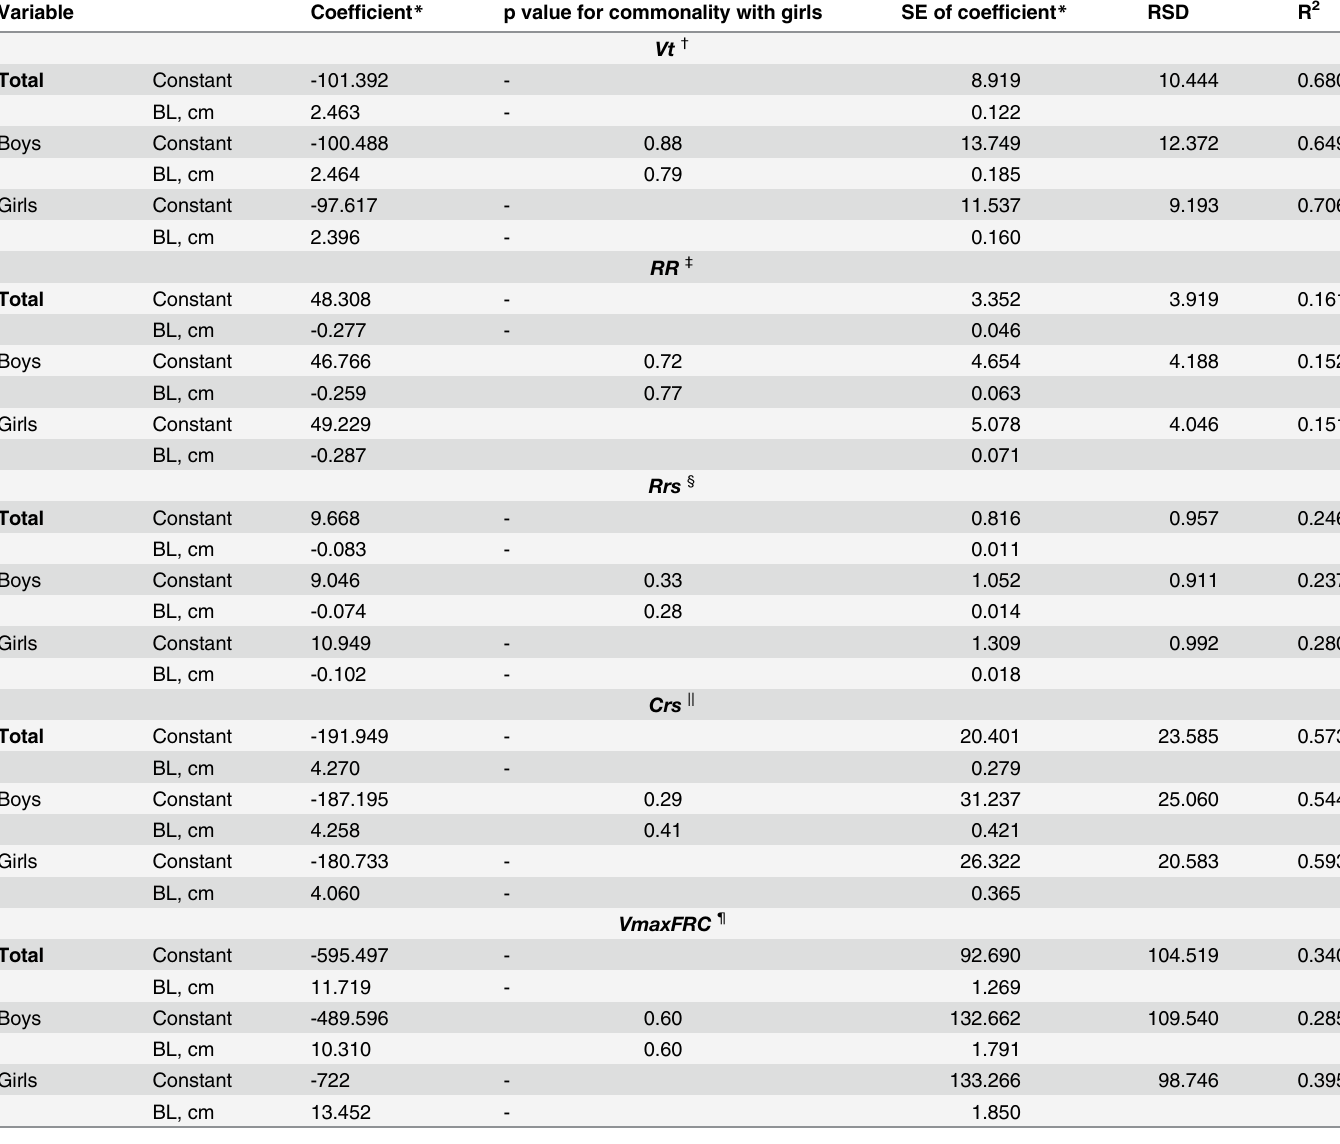
Table 4. Regression equations of various parameters of infant lung function.